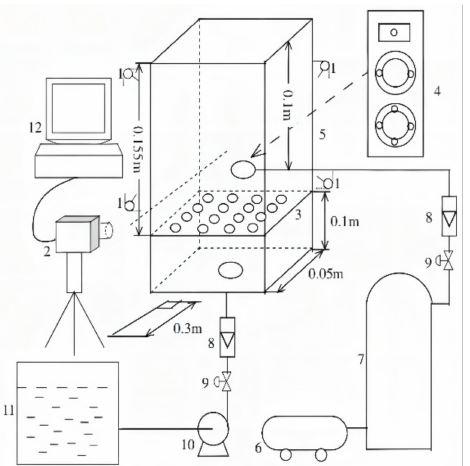
Figure 8. Schematic diagram of the gas–liquid bubble column with single- or multiple-orifice gas distributors. (1) Incandescent lamp; (2) CMOS high-speed camera; (3) liquid distributor; (4) gas distributor; (5) bubble column; (6) air compressor; (7) air storage tank; (8) rotameter; (9) regulating valve; (10) centrifugal pump; (11) liquid storage tank; (12) personal